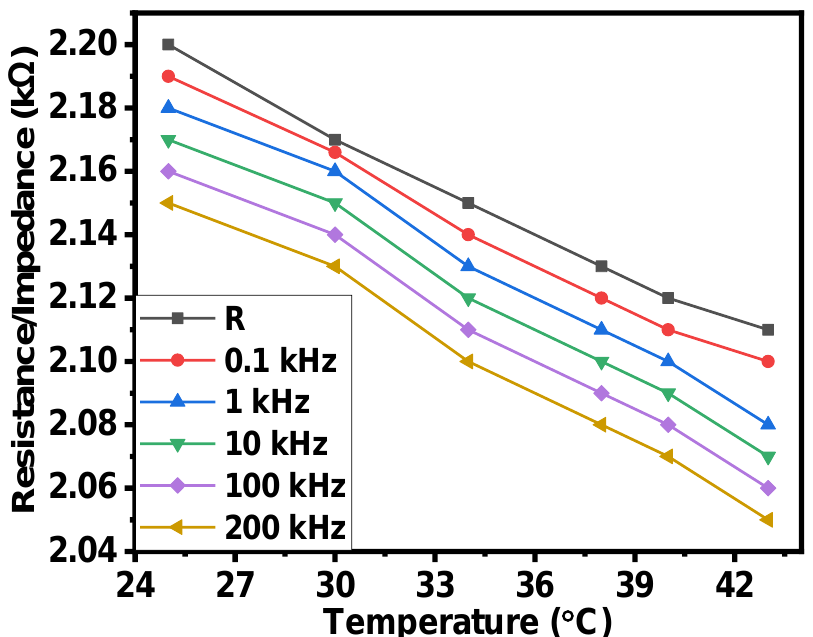
Figure 6. Resistance/impedance – temperature relationships of the surface-type shockproof resistor based on NiPc – oil jelly and CNT – oil jelly – rubber composites. The temperature coefficient of resistance (TCR) may be calculated as: